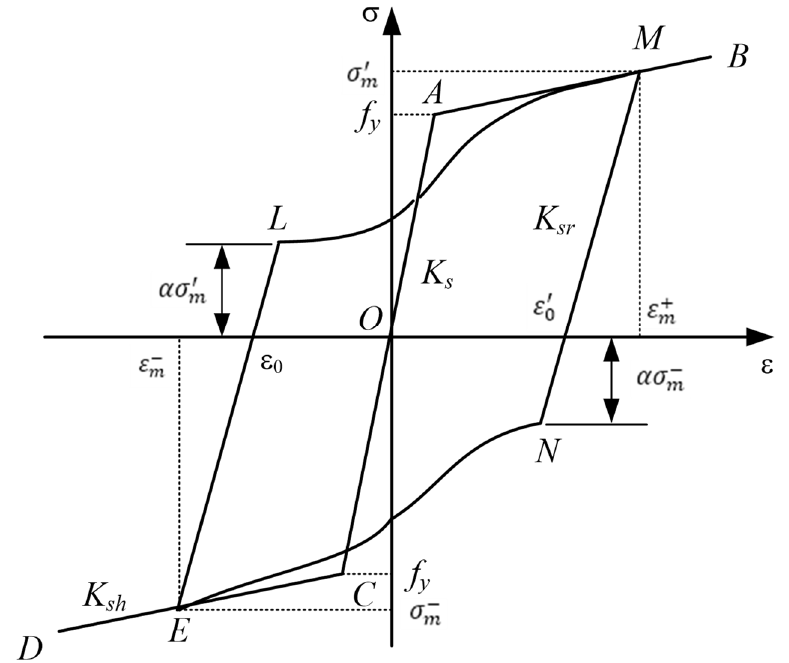
Figure 17. A constitutive model of the rebars.